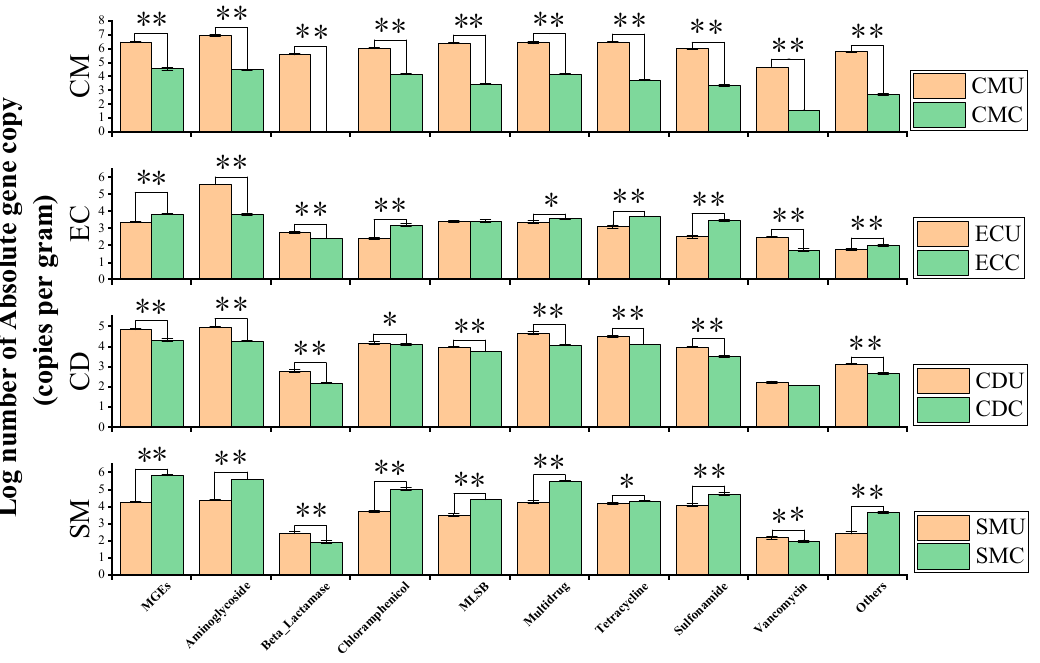
Figure 6. Log number of absolute gene copy number (copies per gram) of ARGs and MGEs. The histogram showing the distribution of di ff erent types of ARGs (classified by the classes of antibiotics that they resisted) and MGEs in the four groups of organic fertilizers before and after composting. ** ( p < 0.01) on the bar indicates a statistically significant di ff erence. * ( p < 0.05) on the bar indicates a statistically significant difference.